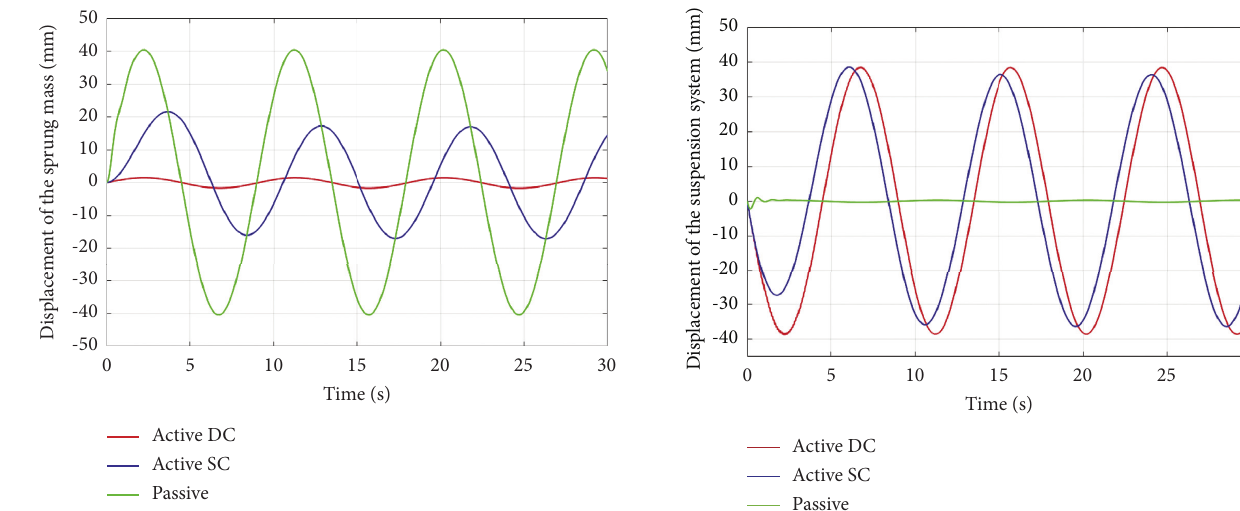
Figure 5: Displacement of the sprung